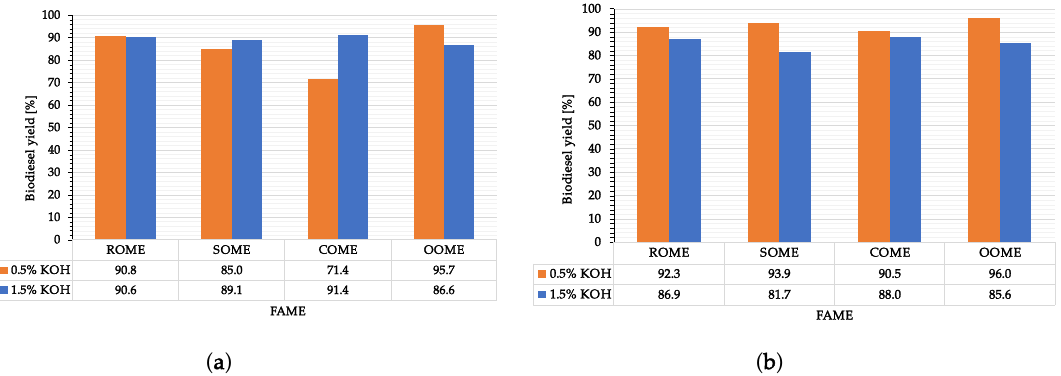
Figure 2. The yield of biodiesel obtained from vegetable oils in the presence of KOH. [Reaction time ( a ) 1 h and ( b ) 4 h].